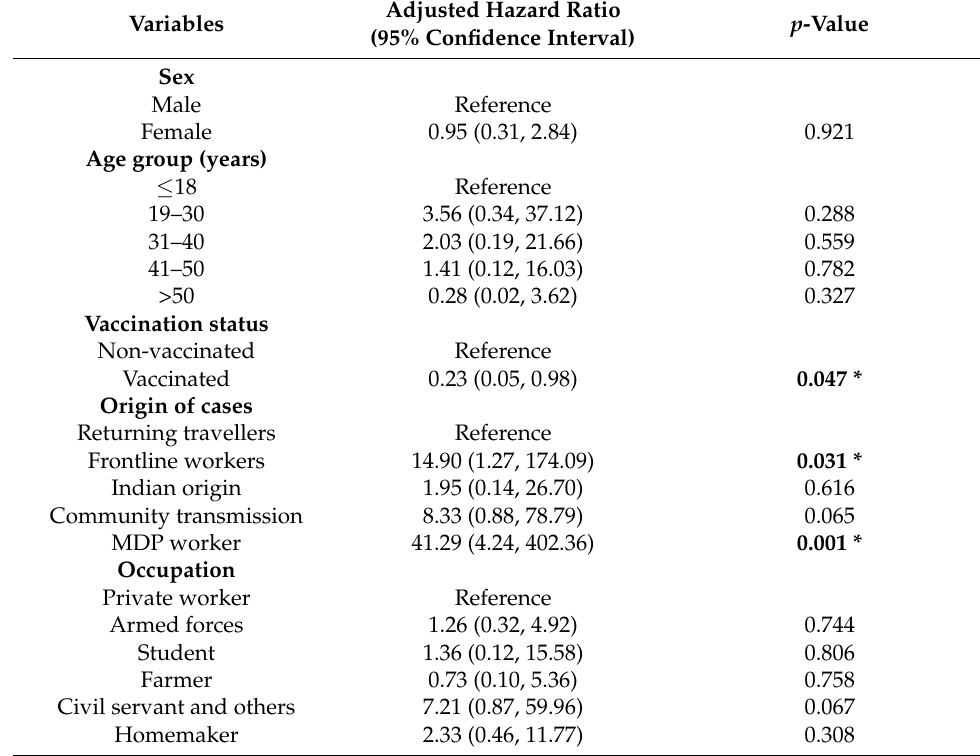
Figure 5. Kaplan–Meier estimator: comparison of the probability of occurrence of a disease (with symptoms) for patients with COVID-19 in the Phuentsholing municipality, Bhutan, for different variables. * significant at p < 0.05. Table 3. Multivariable Cox proportional hazard model showing the adjusted hazard ratios of the different variables of COVID-19 patients in the Phuentsholing isolation